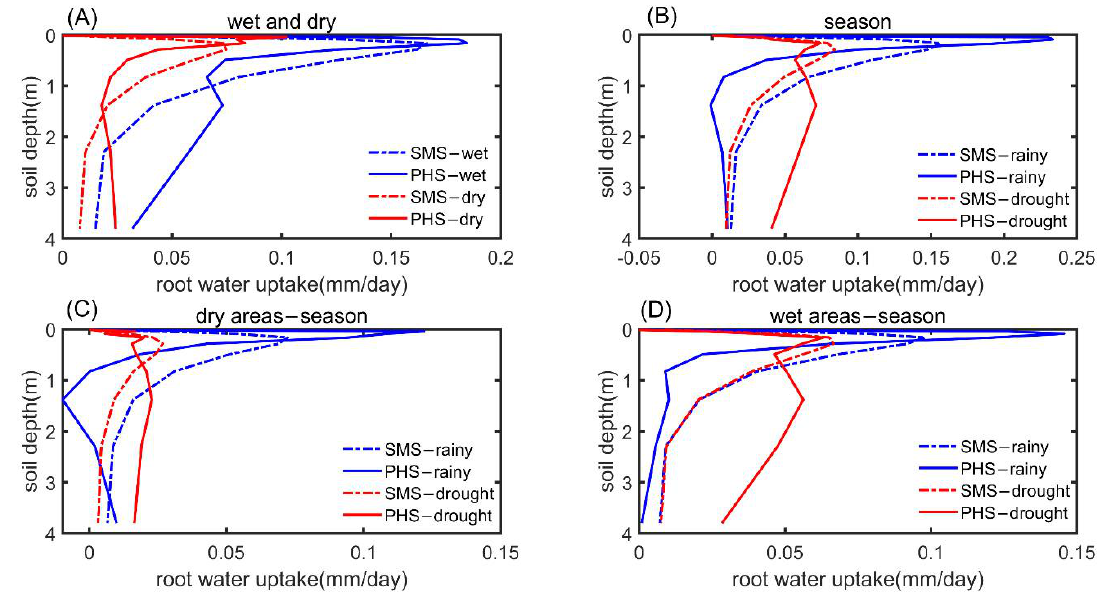
Figure 7. The root water uptake at different depths (mm/day). The vertical profiles are averaged over ( A ) wet sites versus